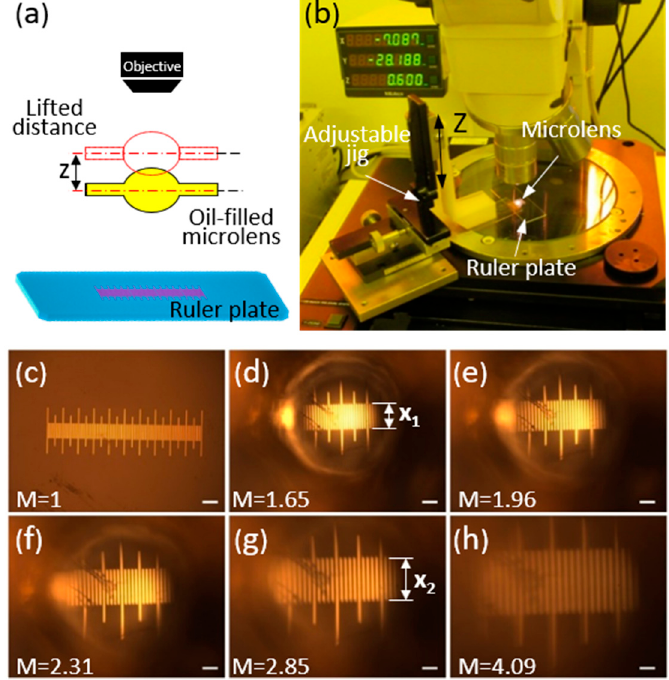
Figure 5. The 500 µm-thick oil-filled microlens used in an optical evaluation experiment setup and the obtained results. ( a ) The concept image of the experiment. The distance from the microlens to the glass micro-ruler plate changes. ( b ) Photo of the actual experimental setup. The microlens was attached to the jig holder and placed over the micro-ruler plate under the microscope. ( c – h ) Images captured at different distances to the micro-ruler plate, progressively changed by 100 µm from one image to the next. Each scale bar is 100 µm.